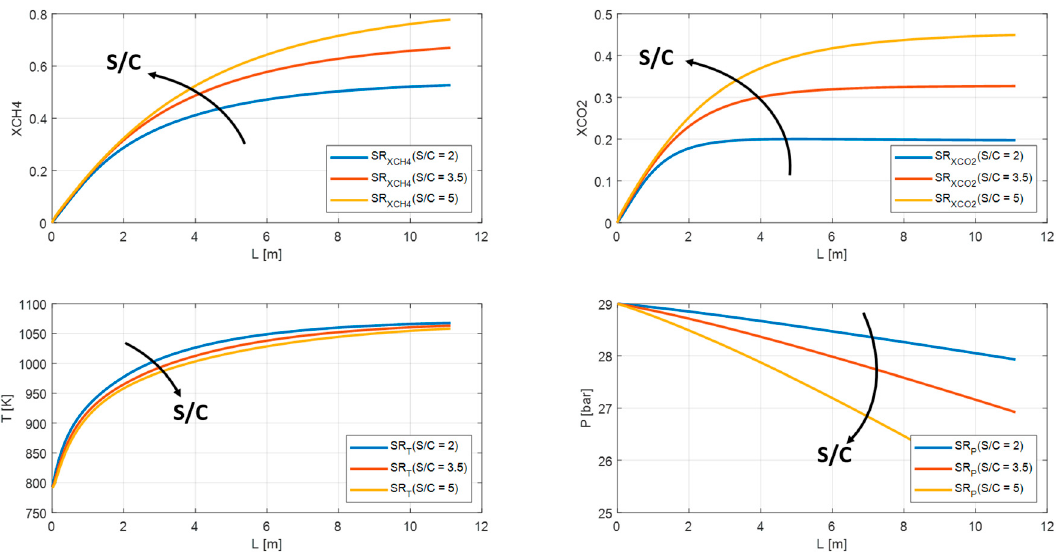
Figure 14. Methane conversion, carbon dioxide yield, temperature, and pressure profile in SR for S/C = 2, S/C = 3.5, S/C = 5.